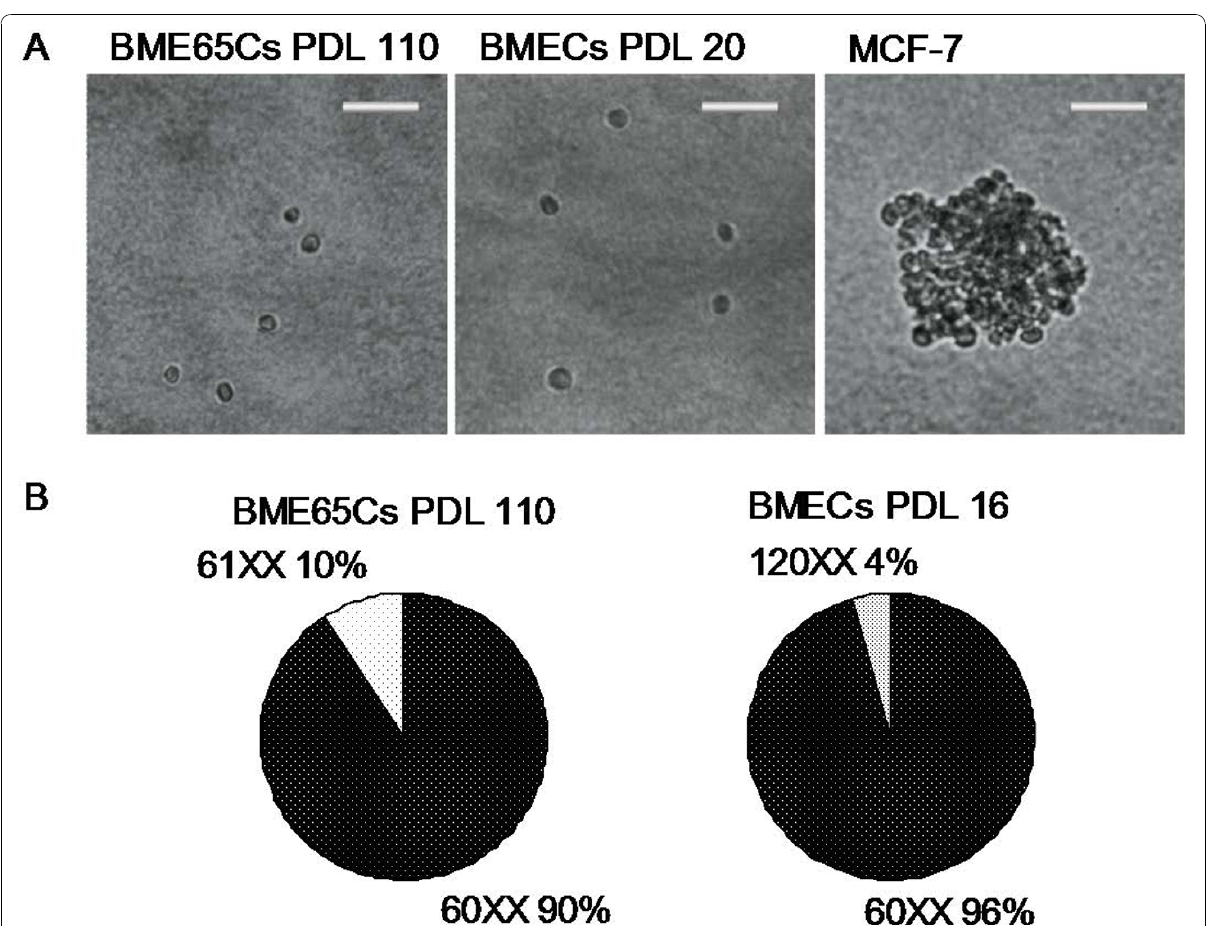
Figure 4 Soft agar assay and karyotype analysis in immortal BME65s cells and early passage BMECs cells . A . Analysis of colony formation used for evaluating malignant potential by the soft agar assay. Colonies containing more than ten viable cells were scored positive. Obvious colony formation was shown in MCF-7 cells, which served as a positive control. Bars: 50 μ m. B . Comparison of chromosome numbers. At least 20 well-spread metaphase chromosomes from immortal BME65Cs cells (passage 110) and BMECs cells (primary passage16) were examined and the characteristic patterns illustrated were